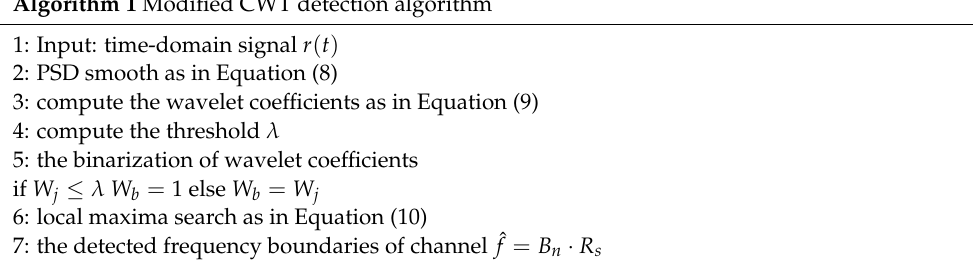
Algorithm 1 Modified CWT detection